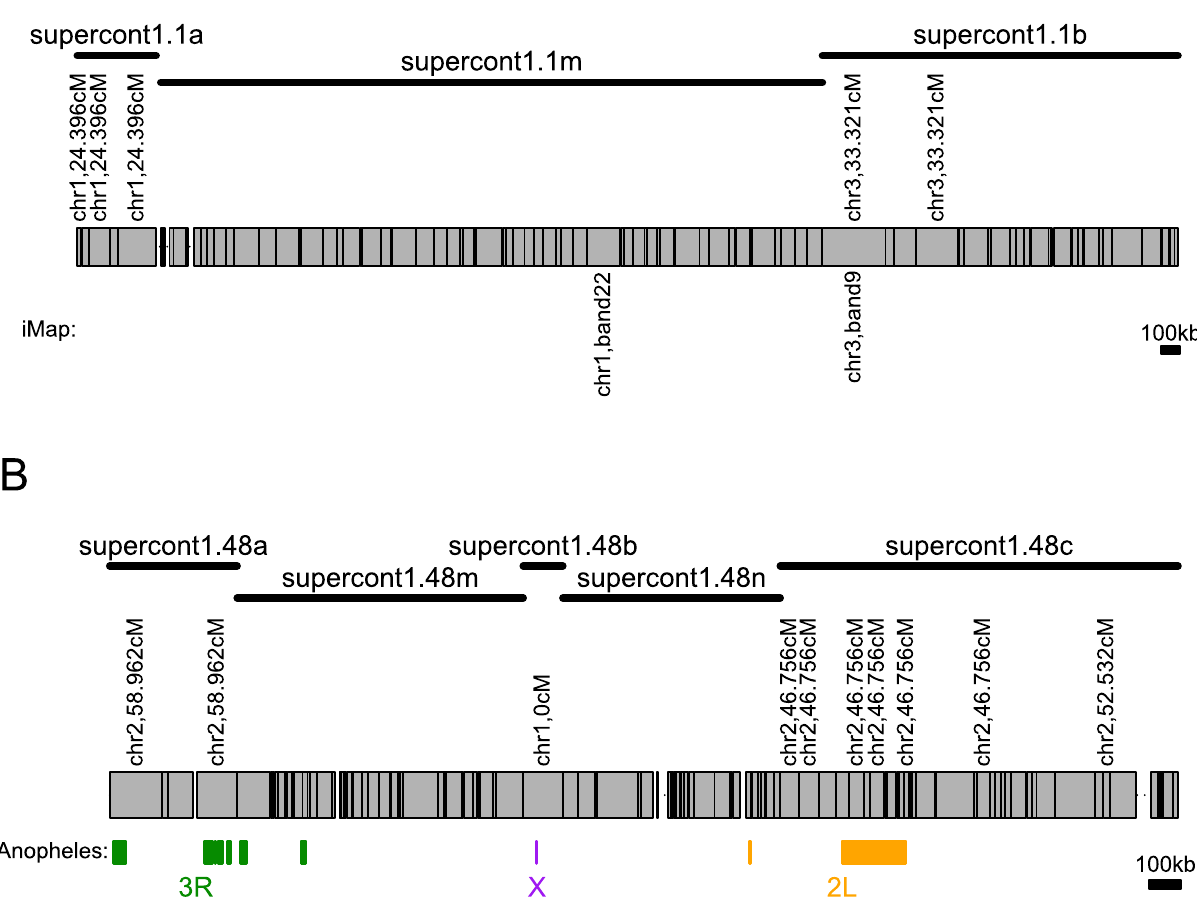
Figure 1. Examples of two misassembled scaffolds. Individual contigs are shown as gray rectangles. Contigs with markers in this study are indicated with an * above the scaffold and are labeled with their position on the genetic map. The new scaffolds created by splitting misassemblies (identified in this study only) are shown with solid lines. New scaffolds with suffixes ‘a,’ ‘b,’or ‘c’ contain markers that allow placement on the genetic map. New scaffolds with suffixes ‘m’ or ‘n’ fall between conflicting markers and therefore contain a misassembly and cannot be placed on the genetic map. A) Supercontig 1.1 with markers from the previously published integrated map [20] shown below. The mapping of markers to two different chromosomes indicates a misassembly within the scaffold, which is supported by both markers sets. B) Supercontig 1.48 with synteny with An. gambiae shown below the scaffold and the different colors indicating different chromosome arms. Both our markers and syntenic breaks with An. gambiae indicate that this scaffold is misassembled in at least two instances.